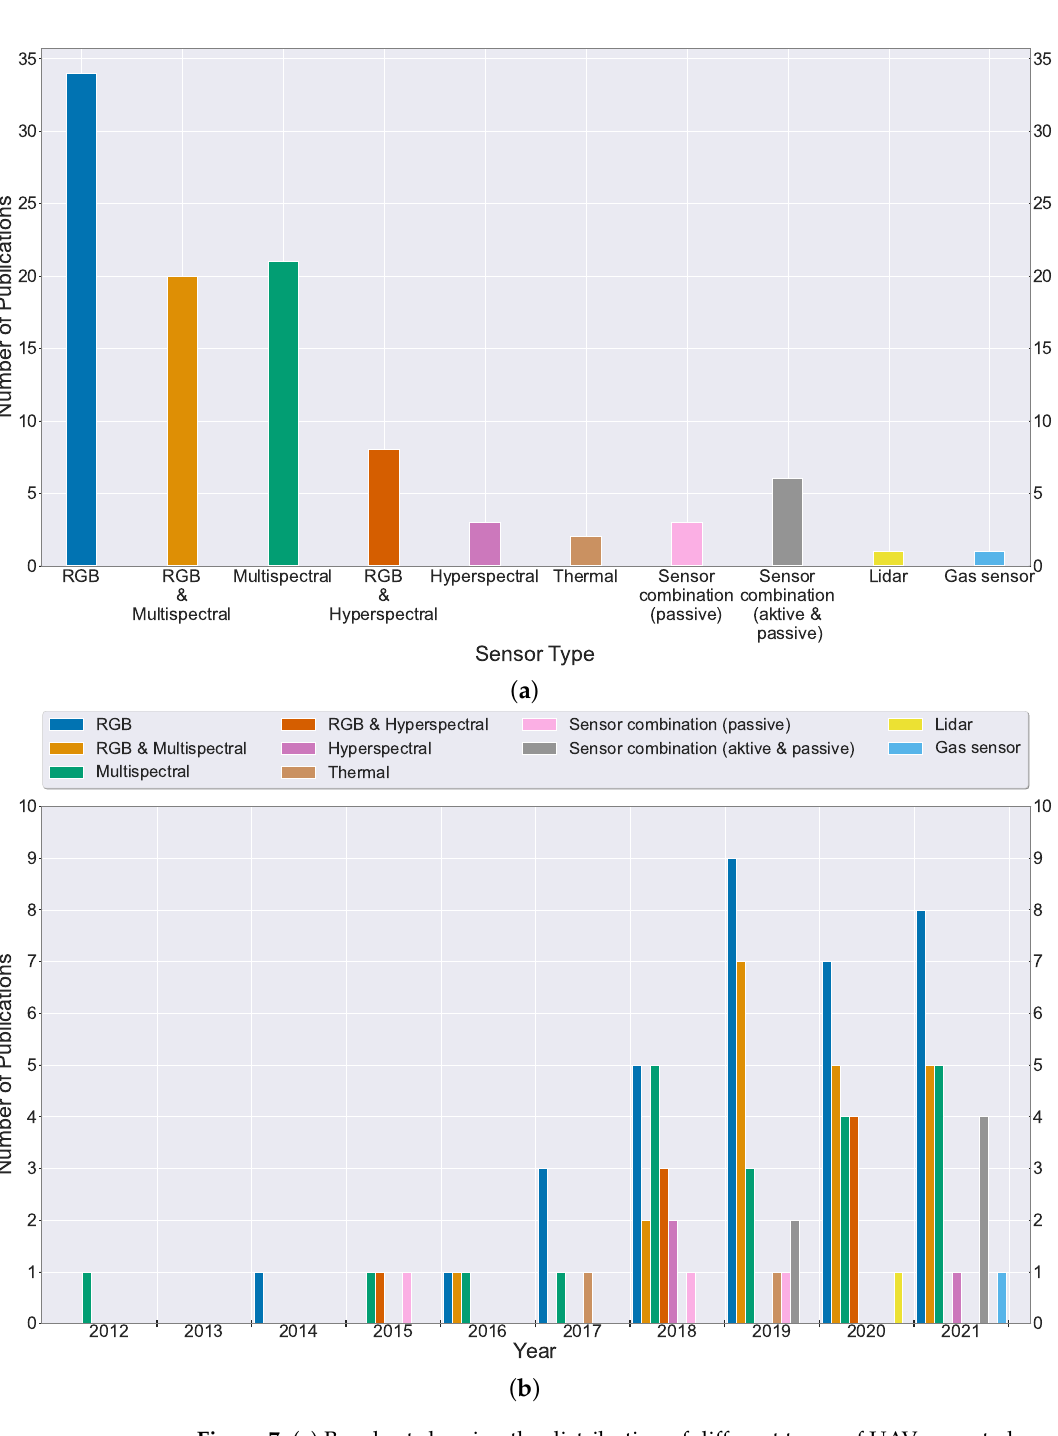
Figure 7. ( a ) Bar chart showing the distribution of different types of UAV-mounted sensors used for forest health monitoring in the literature dataset. ( b ) Bar chart showing the number of different types of UAV-mounted sensors used for forest health monitoring per year over the selected publication date